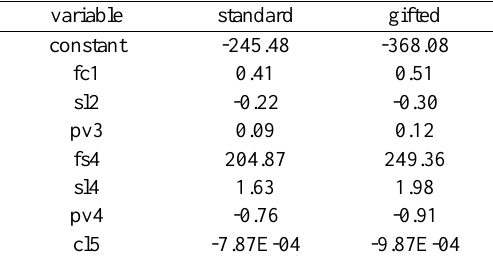
Table 6 Discriminant analysis brief report